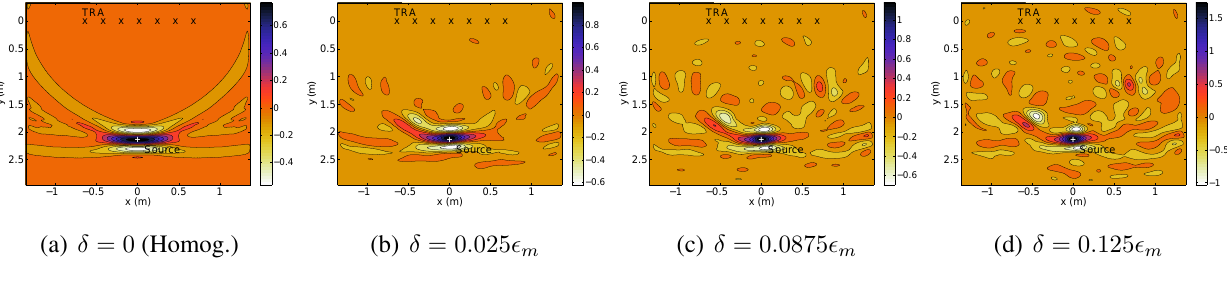
Figure 3. Spatial distribution of the time-reversed E at the time of refocusing for increasing δ and fixed l scale.